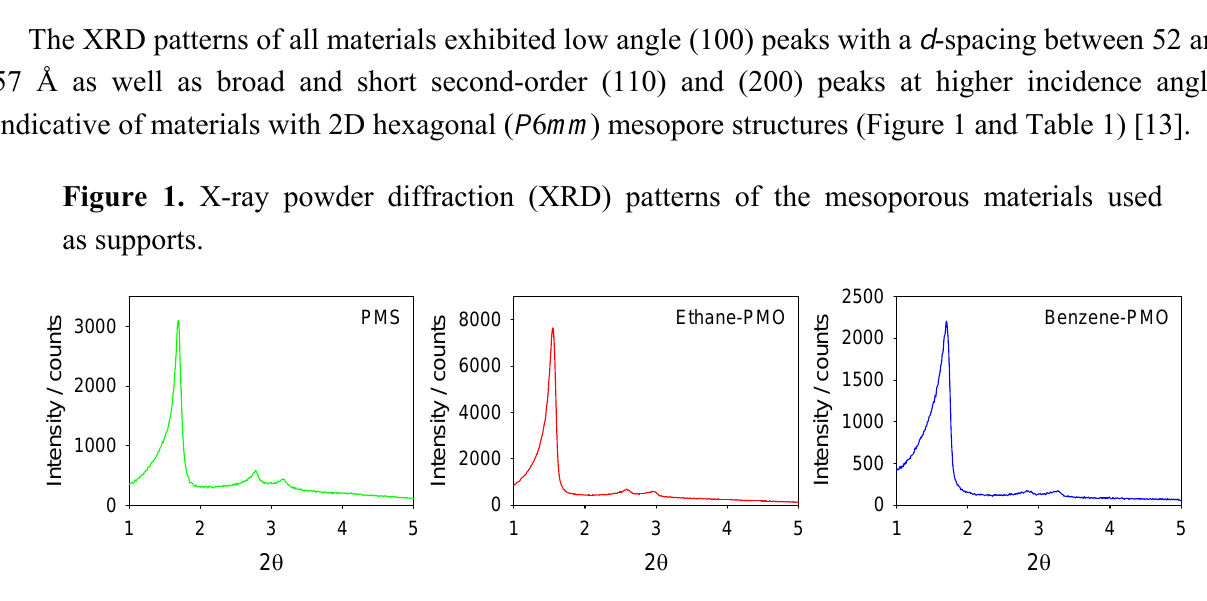
Table 1. Physicochemical properties of periodic mesoporous